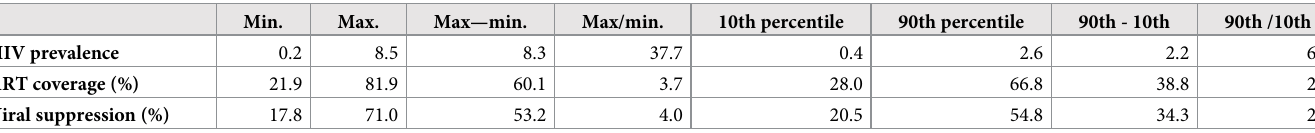
Table 2. Differences in HIV indicators between local government areas (LGAs; n = 774) in Nigeria (2018). Min. Max. Max—min. Max/min. 10th percentile 90th percentile 90th - 10th 90th /10th HIV prevalence 0.2 8.5 8.3 37.7 ART coverage (%) 21.9 Viral suppression (%)